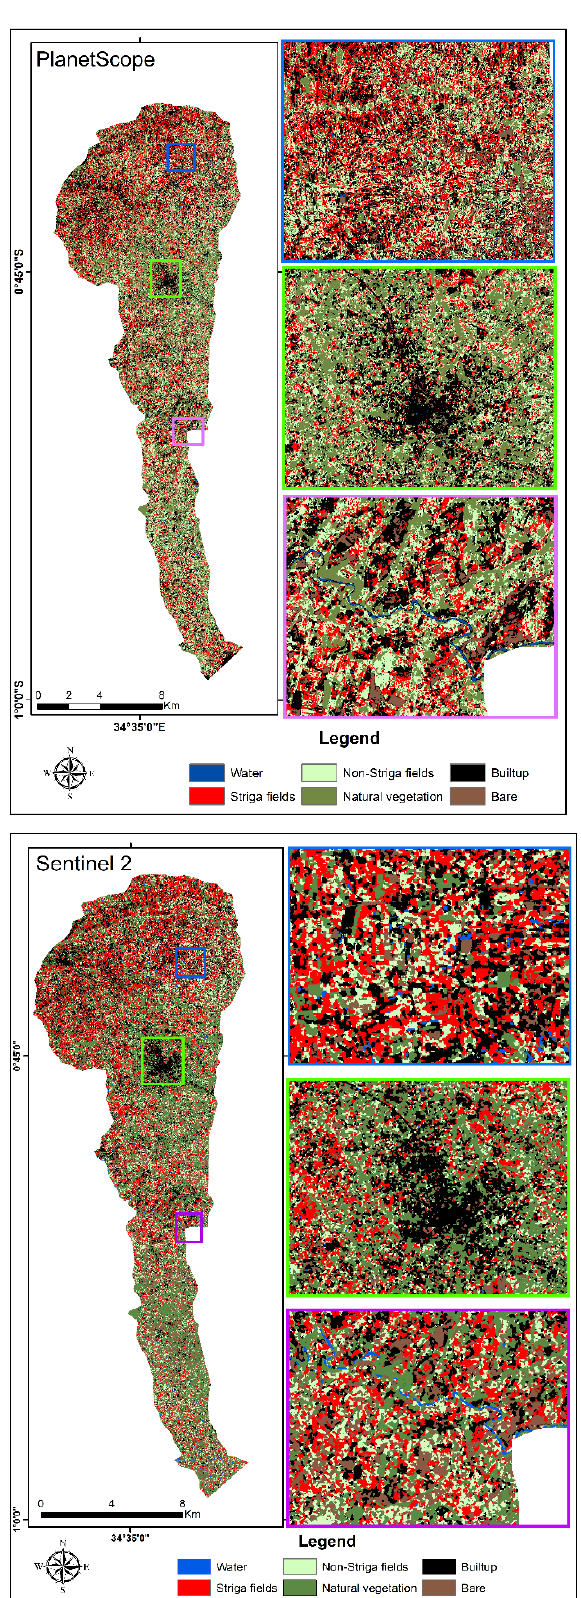
Figure 4: Land use and land cover map of Rongo showing the distribution of Striga infested fields from the GRRF classification of PlanetScope and